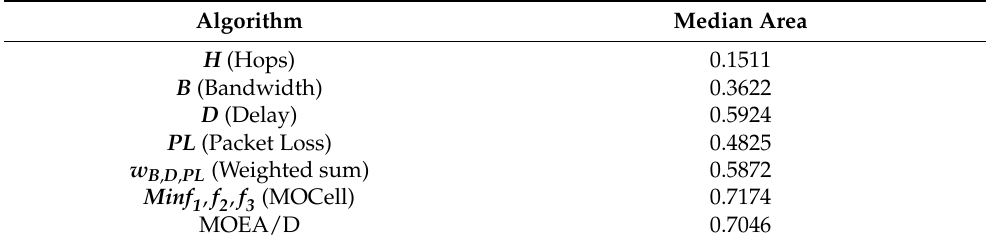
Figure 11. TCP performance of paths. Time interval 200 s. STDEV: 𝐻 = 0.01847, 𝐵 = 0.04224, 𝐷 = 0.02953, 𝑃𝐿 = 0.09682, 𝑤 (cid:3003),(cid:3005),(cid:3017)(cid:3013) = 0.13832, 𝑀𝑖𝑛𝑓 (cid:2869) , 𝑓 (cid:2870) , 𝑓 (cid:2871) = 0.03777, and MOEA/D = 0.04104. Table 5. Routing Paths Throughput Areas.